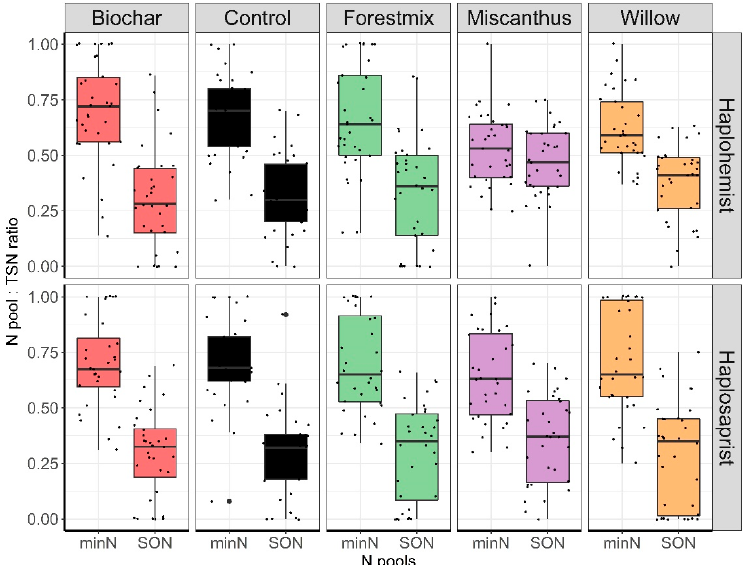
Figure 6. Distribution of the MinN:TSN ratios and SON:TSN pools as a function of soil type and treatment. (B = biochar, M = miscanthus, FM = forest mix, W = willow, C = control).